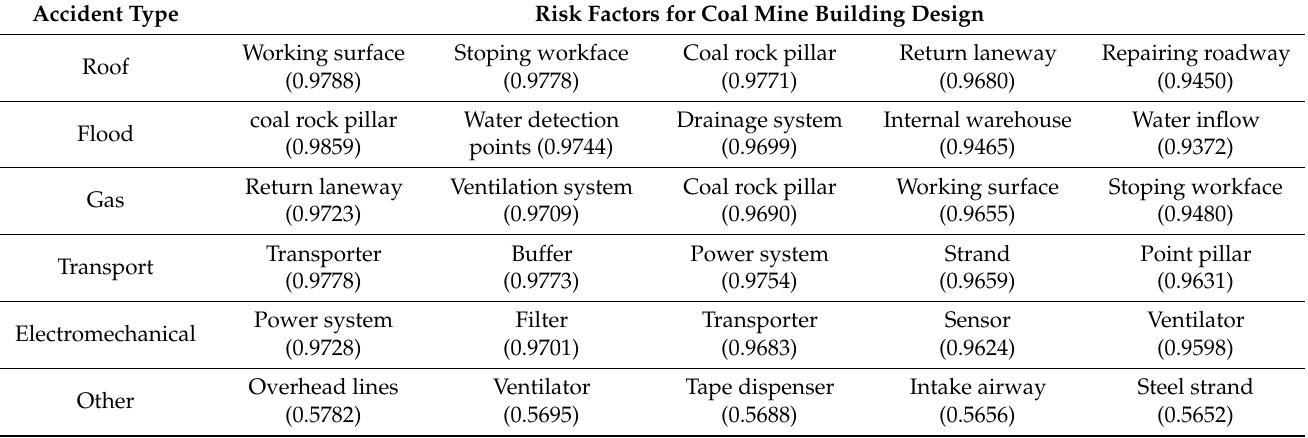
Table 1. Key coal mine building elements and